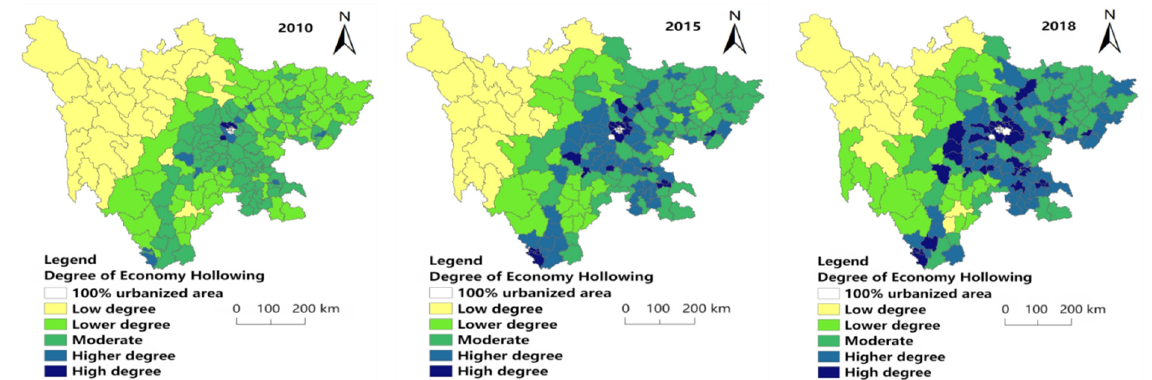
Figure 6. Spatial distribution of economy hollowing degree in 2010, 2015 and 2018.